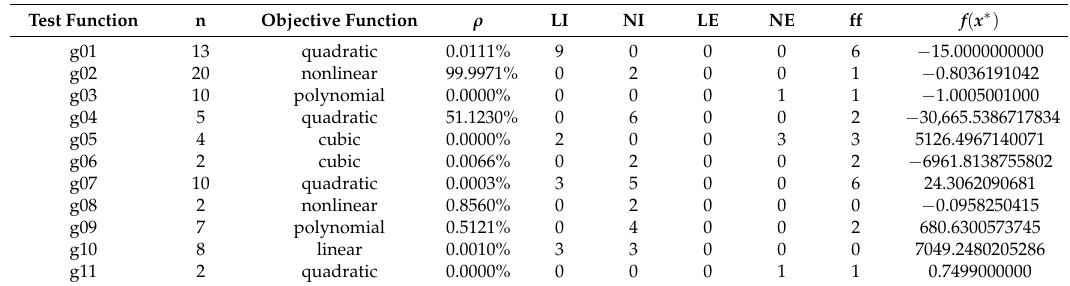
Table 1. Benchmark test functions.